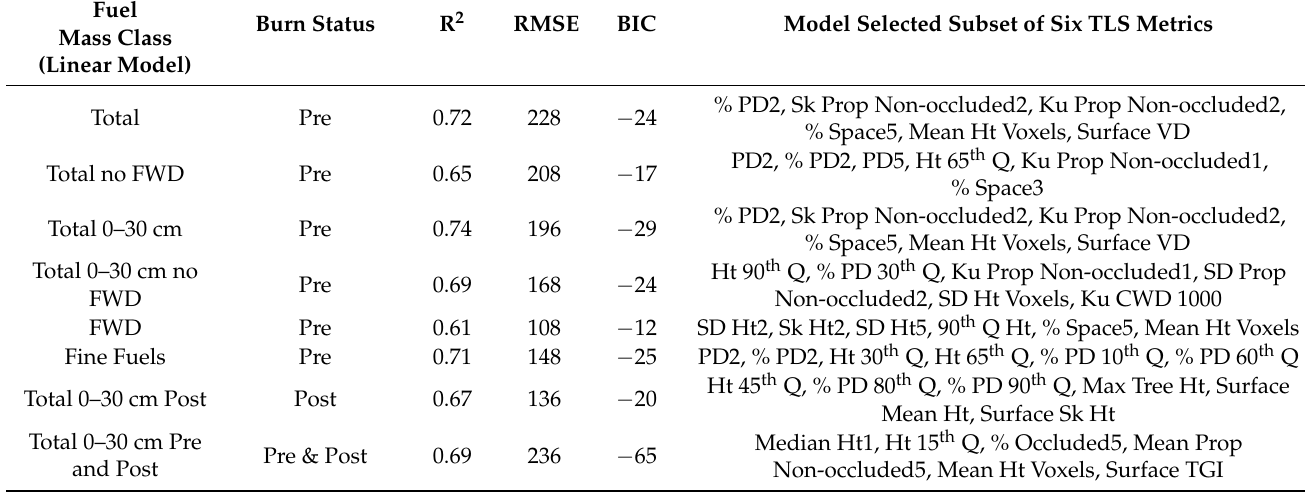
Table 1. Statistical results from leaps and bounds linear regression, which illustrate the resulting model selected subset of six TLS metrics used to predict the associated vegetation and fuel mass classes (linear models). All models had a df = 34, except Total 0–30 cm Pre and Post, which had df = 75. See Appendix C for a full list of metrics and their definitions. All models resulted in a p -value of